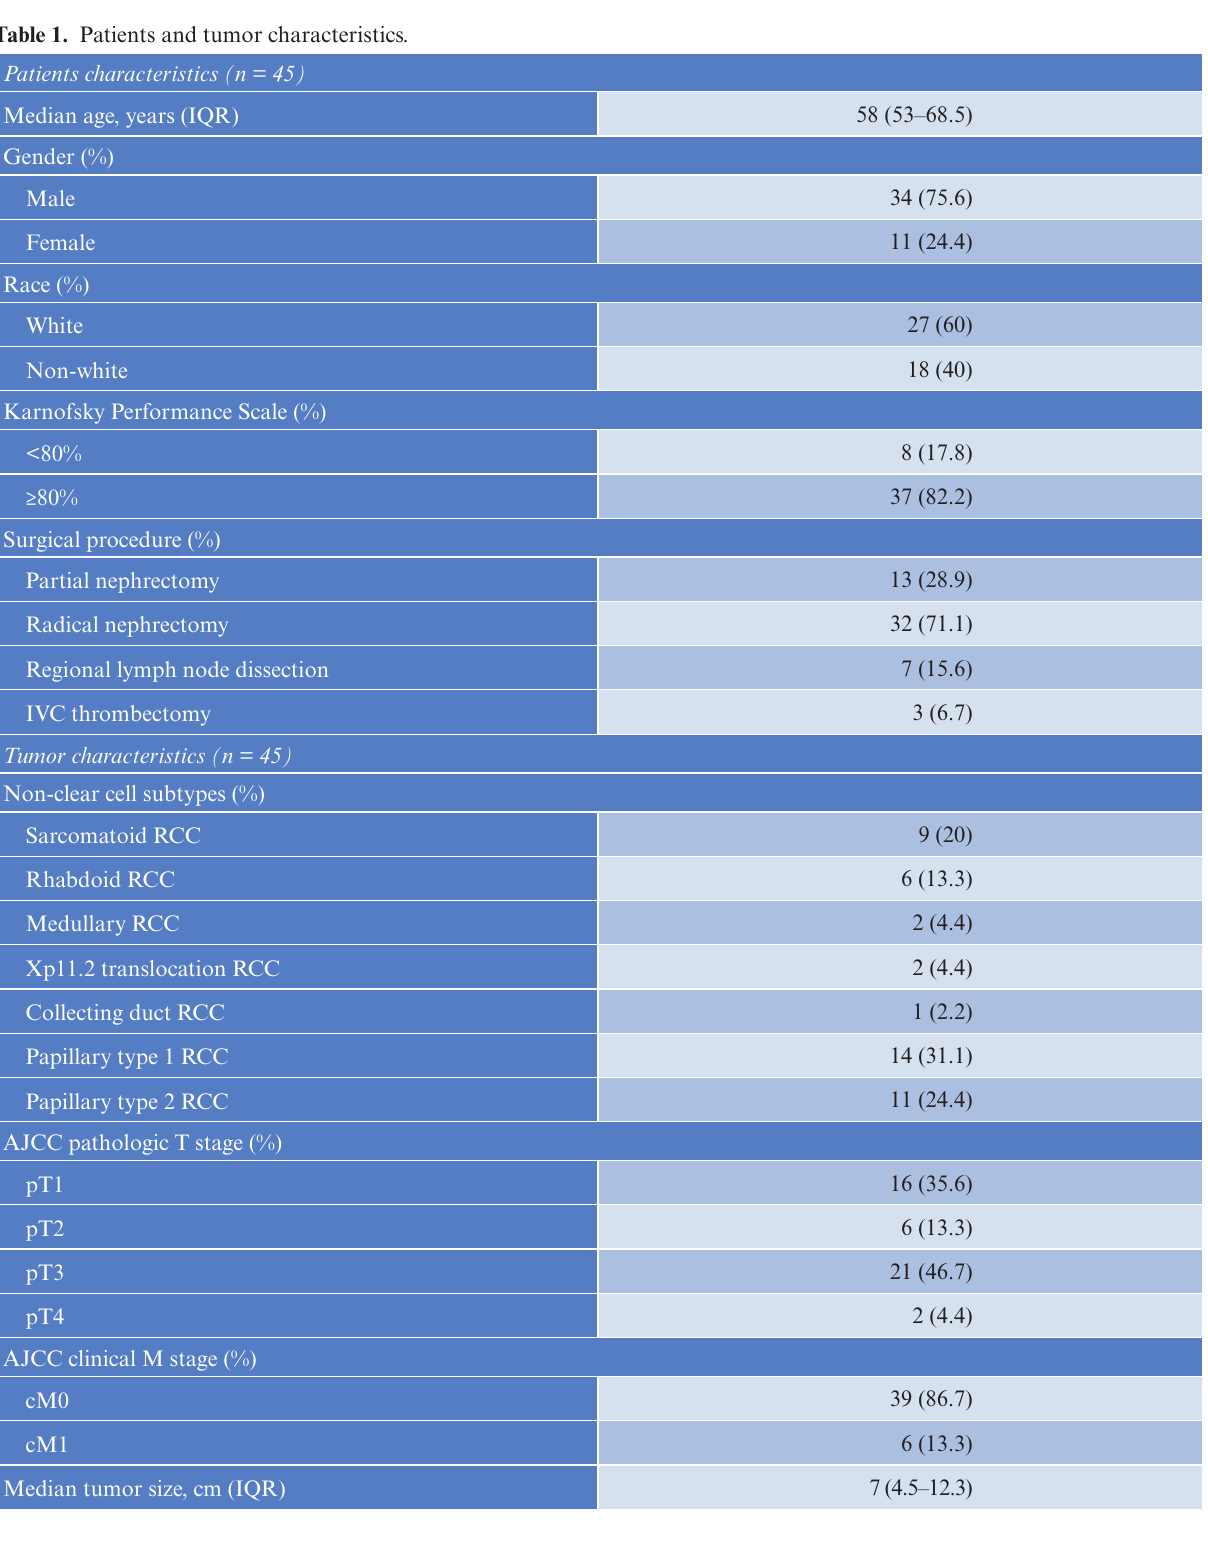
Table 1. Patients and tumor